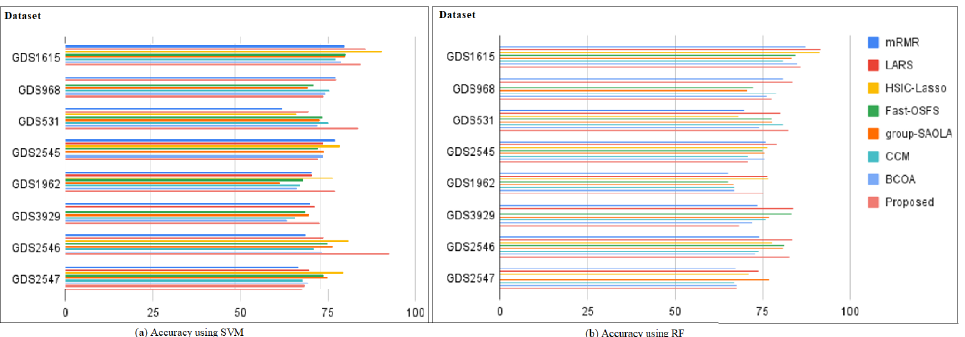
Figure 4. Comparison of different feature selection techniques using support vector machine and random forest on different